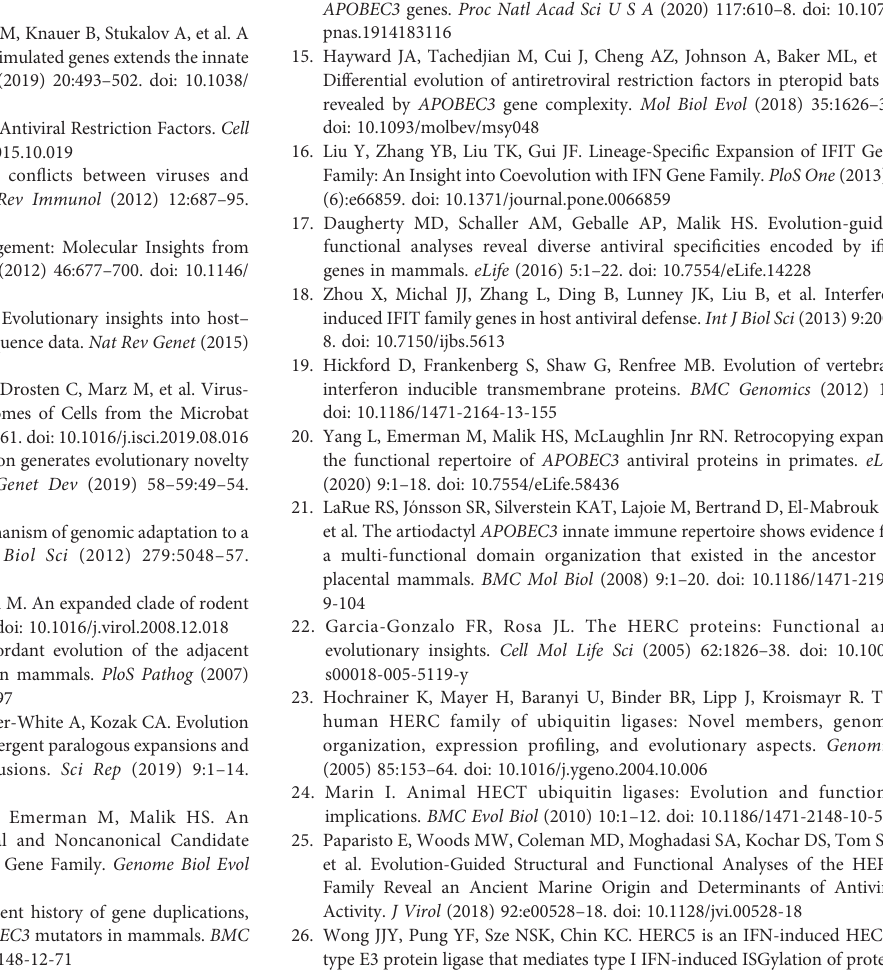
carnivore HERC6 , highlighting a conserved stop codon in the cetacean species (codon 174 in Balaenoptera acutorostrata ). Nucleotide and amino acid sequences are shown using Geneious. SUPPLEMENTARY FIGURE 3 | Maximum likelihood phylogenetic tree generated with the whole coding sequences of HERC5 , HERC6 , HERC5/6 , and HERC3 nucleotide alignment in bats (left) and rodents (right). The chimeric duplicated HERC5/6 genes are shown in red. Asterisks indicate bootstrap values greater than 80%. The scale bar at 0.2 is indicated below. SUPPLEMENTARY FIGURE 4 | Alignment of the protein sequence of HERC5, HERC5/6, and HERC6 from bats and rodents. The percentages of pairwise amino acid identities between the N-terminals of HERC5/6 and HERC5 or HERC6, as well as the C-terminals of HERC5/6 and HERC5 or HERC6 are indicated. The signi fi cant recombinationbreakpoints(redarrows,p-value <0.05)assigned byGARDprogram are shown for bat and rodent HERC5/6 gene. Because the coding sequence of HERC6 gene from Heterocephalus glaber was incomplete with many missing data, it was not included in the fi gure. Likewise, some portions of the N-terminal of HERC5, as well as the C-terminals, from HERC5/6 and HERC6 are missing in the protein alignment of the chiropteran species, Myotis brandtii (top). SUPPLEMENTARY TABLE 1 | Information on publicly available datasets analyzed in this study. Accession numbers are available in NCBI (https://www.ncbi.